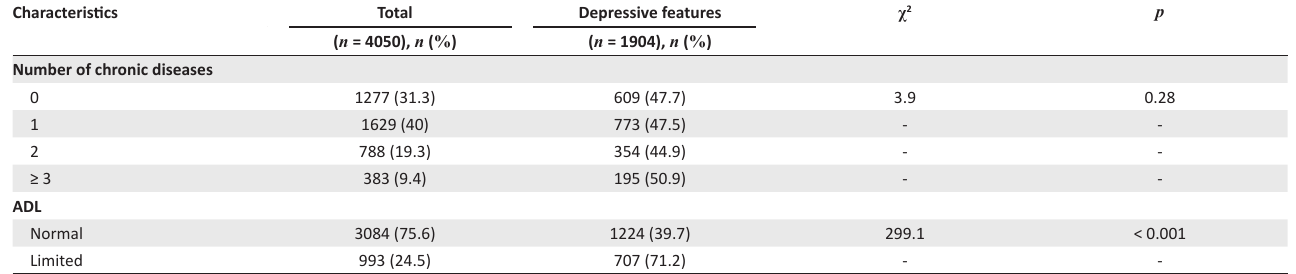
TABLE 4: Comparison of health status and physical function of the elderly by depressive features. Characteristics